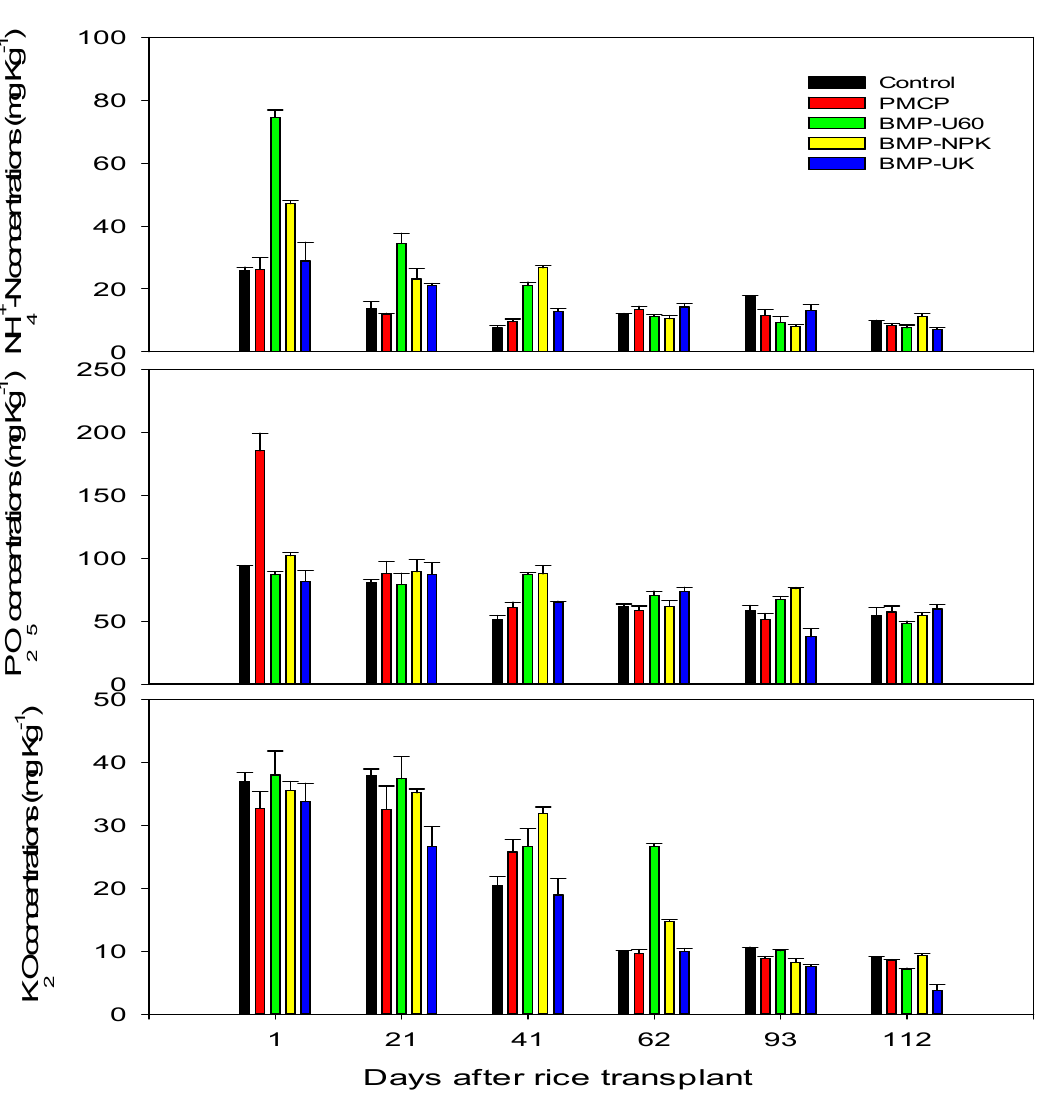
Figure 4. NH 4+ –N, P 2 O 5 and K 2 O concentrations under different treatments in the paddy soil during rice cultivation. The values displayed are averages of triplicate samples with the standard deviation.